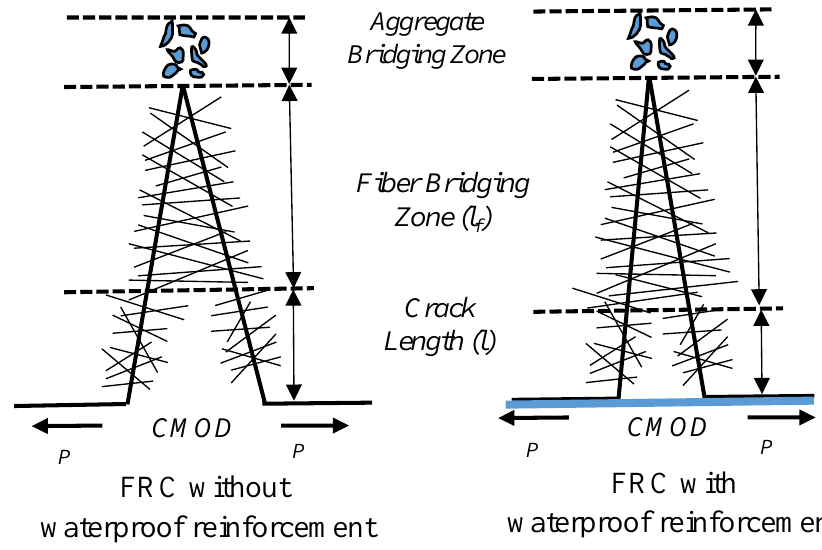
Figure 14. Schematic diagram of the effects of waterproof reinforcement on the fiber bridging zone.